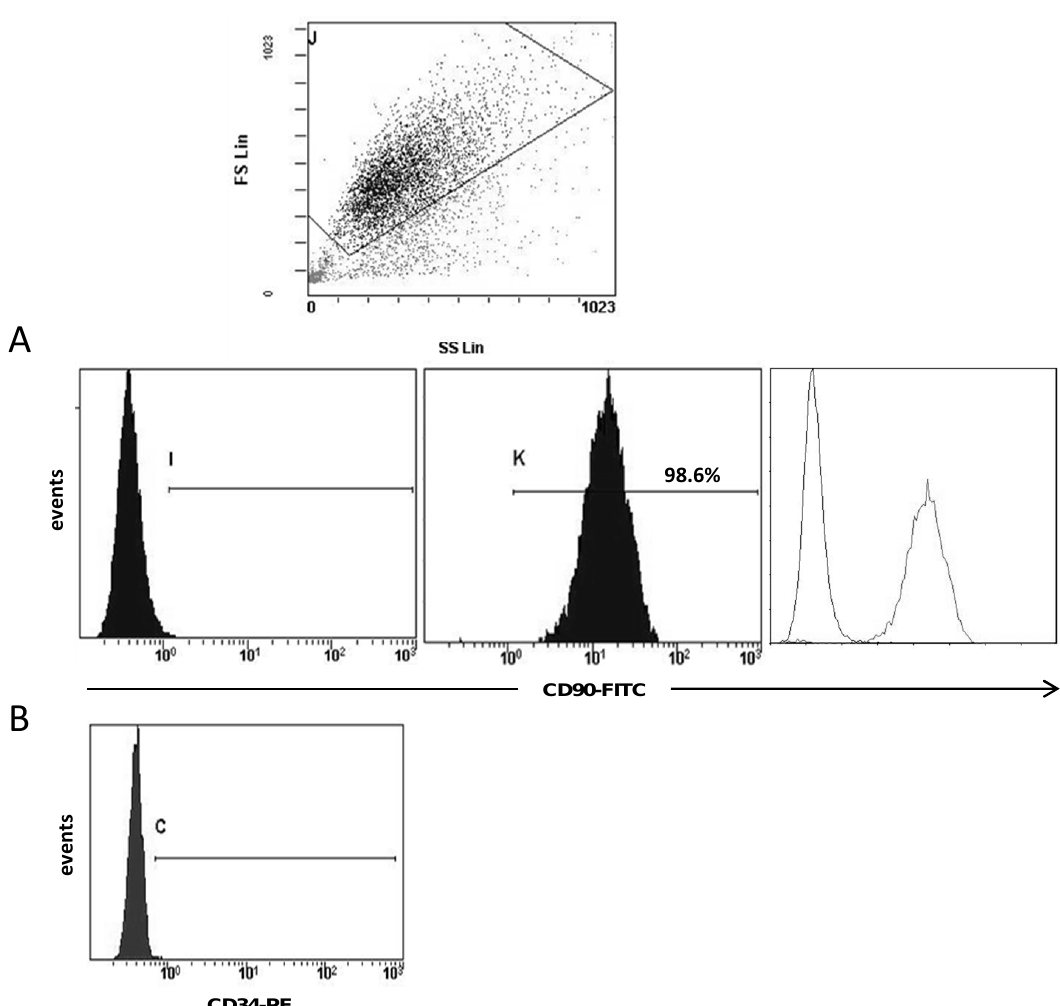
Figure 1. Representative example of flow-cytometry analysis of fibroblast population. At the top it shown a selection of cell population depending on the size and the cellular complexity (SS). ( A ) Negative control, positive expression for CD90 and the overlay. For this analysis all 19 patients were included. ( B ) Negative CD34 expression in a positive CD90 fibroblast